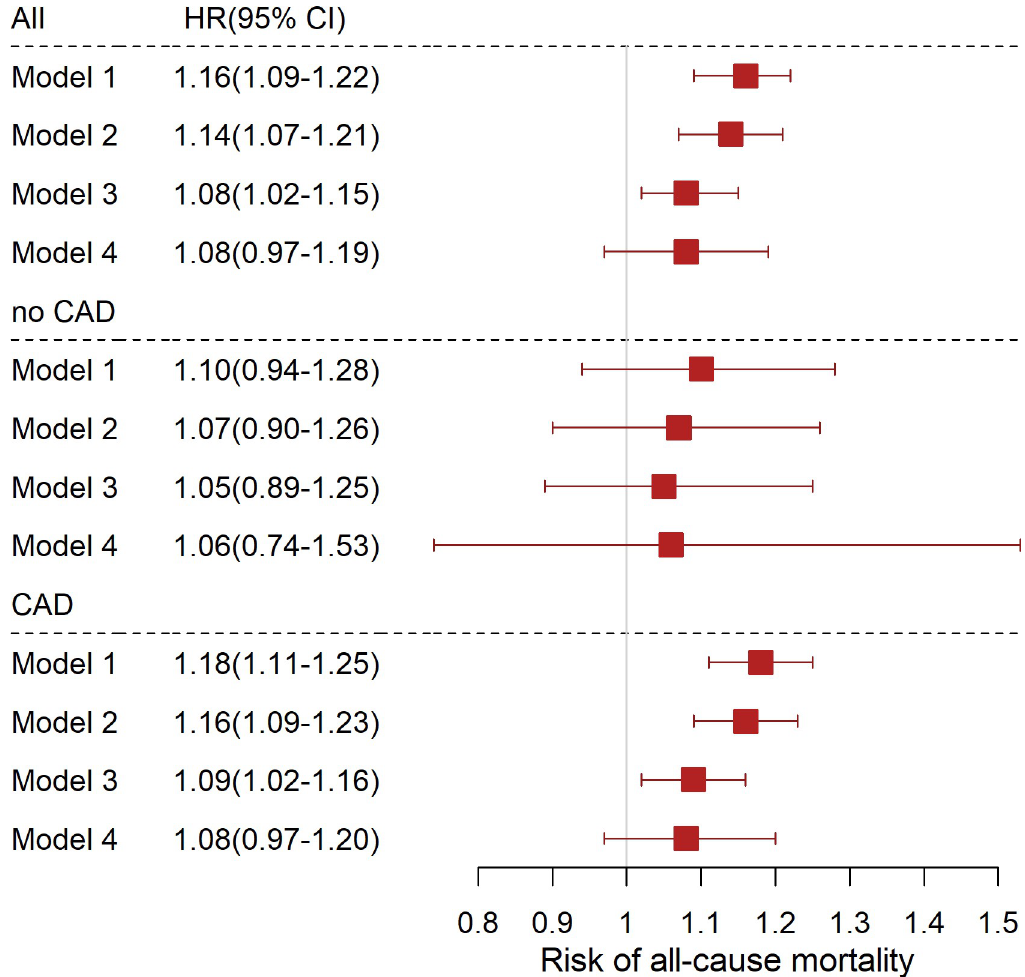
Fig 1. Association of INR and all-cause mortality. Cox proportional hazard regression has been used to calculate the risk of all-cause mortality per 1-SD increase in the INR. Model 1: adjusted for age and gender; model 2: additionally adjusted for BMI, LDL-C, HDL-C, hypertension, diabetes mellitus, smoking status and the use of antiplatelet and lipid lowering drugs; model 3: additionally adjusted for MELD-XI score and history of CAD or heart failure; model 4: model 3 +